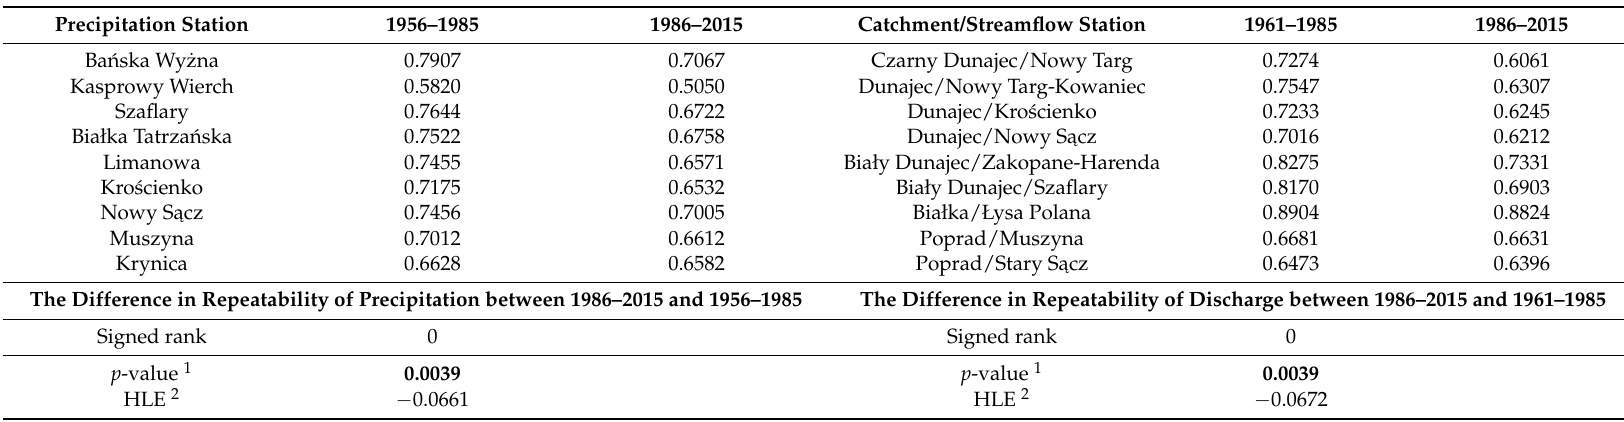
Table 7. The repeatability of monthly precipitation and discharge determined by the coefficient of repeatability. According to the Wilcoxon signed rank test, the median of the difference in repeatability between the most recent 30-year period (1986–2015) and the previous period is significant at p < 0.05. Precipitation